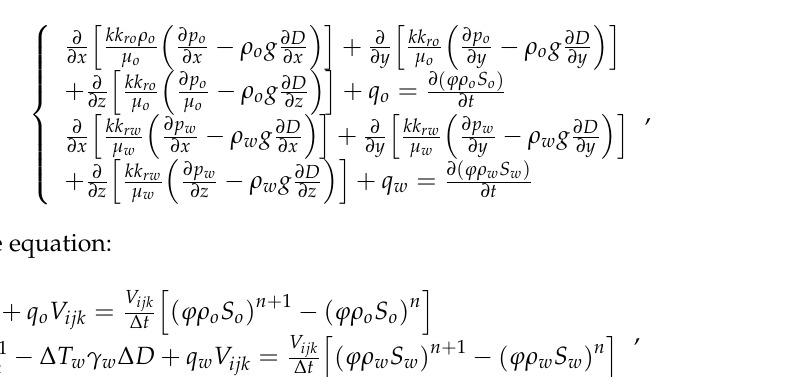
Table 2. Numerical model parameters.